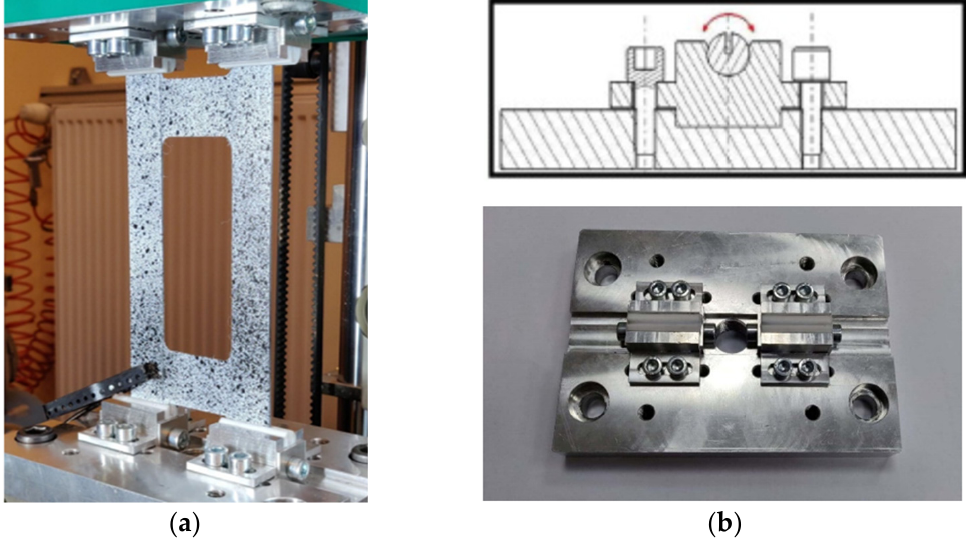
Figure 3. ( a ) Universal testing machine illustrating the plate element under test; ( b ) specially designed grips.